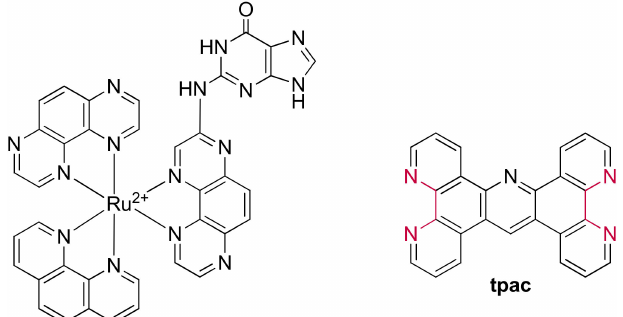
Figure 31. Structure of the photo-adduct of [Ru(TAP) 2 (phen)] 2+ with a guanine base. Structure of the tpac bridging ligand used to form the dinuclear photoactive ruthenium(II)